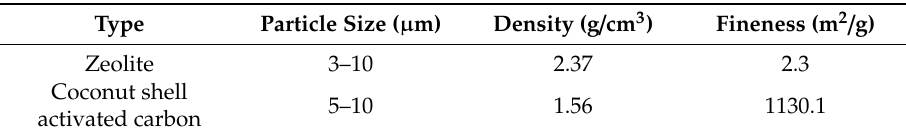
Table 1. Physical properties of porous materials.